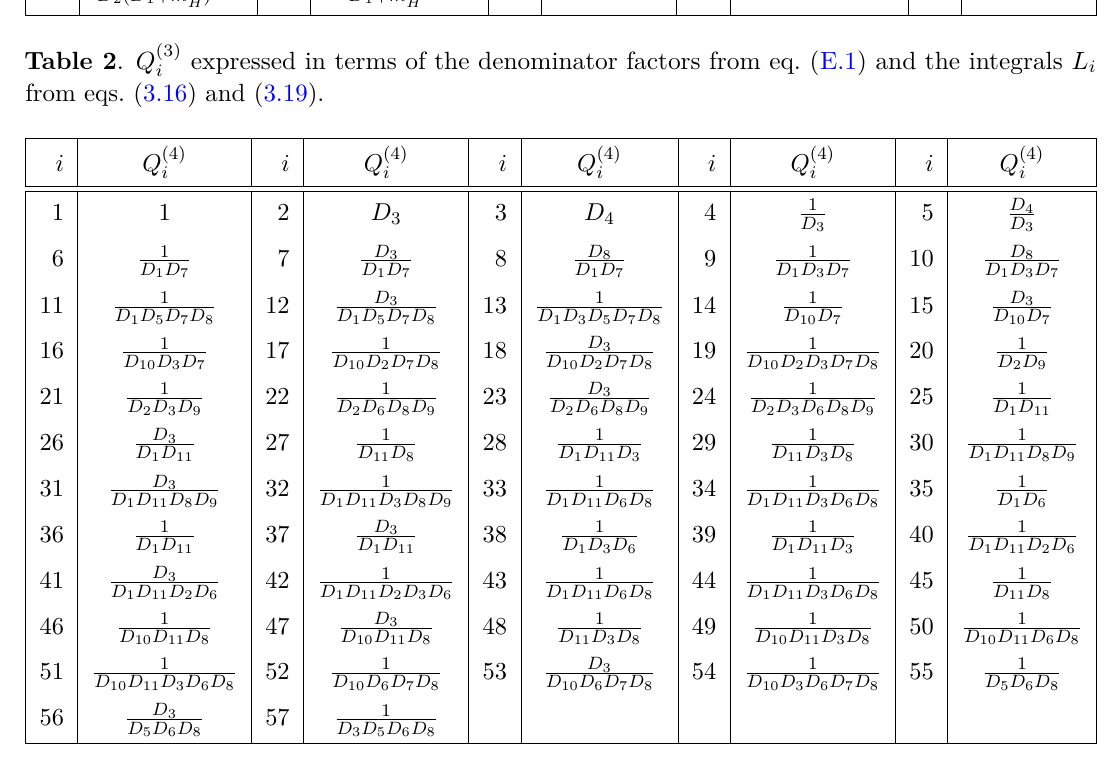
expressed in terms of the denominator factors from eq. Table 3 . Q (4) i